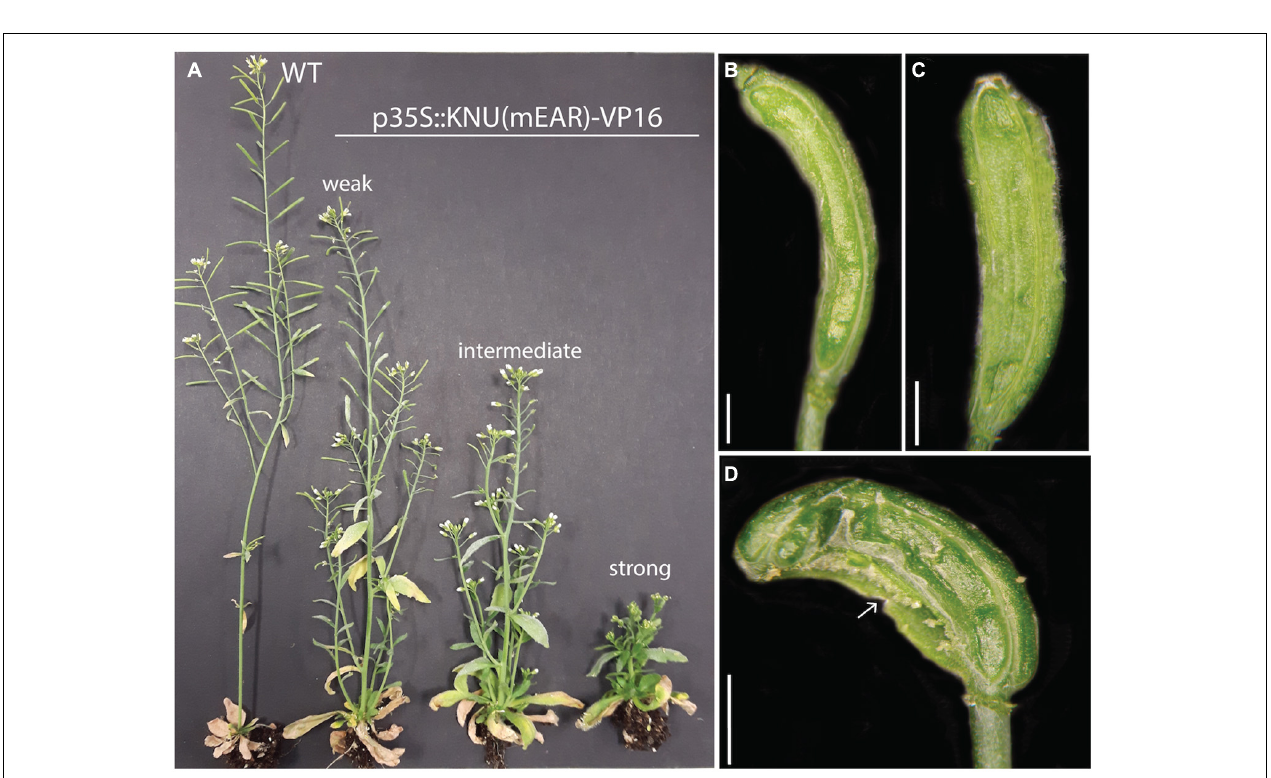
FIGURE 2 | Effects of ectopic expression of a KNU(mEAR)-VP16 fusion protein. (A) A wild-type (WT) plant compared to plants carrying a p35S::KNU(mEAR)-VP16 transgene. Plants of different phenotypic strength are indicated. (B) Tricarpelloid silique of a phenotypically weak plant. (C) Tetracarpelloid silique of a phenotypically intermediate plant. (D) Silique of a phenotypically strong plant with fusion defects (arrow). Scale bars: 1 mm.